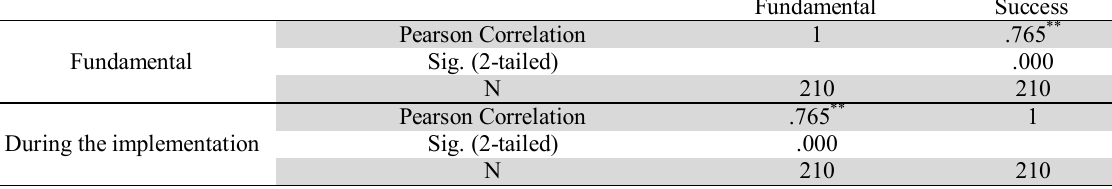
The summary of implementation of Pearson correlation ratio Fundamental Success Pearson Correlation 1 .765 ** Fundamental Sig. (2-tailed) .000 N 210 210 Pearson Correlation .765 ** During the implementation